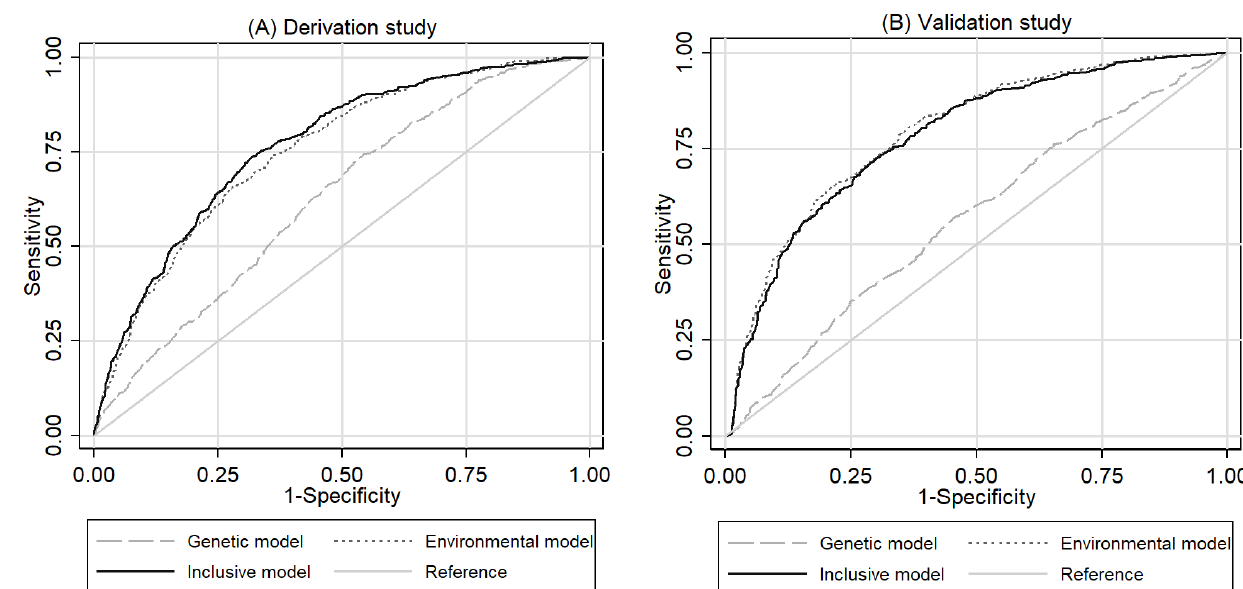
Figure 1. Area under the curve (AUC) of the derivation ( A ) and validation ( B ) studies. In the derivation study, the inclusive model had a statistically significantly higher discriminatory ability than the other models. In the validation study, however, the environmental model was significantly more discriminative than the inclusive model.